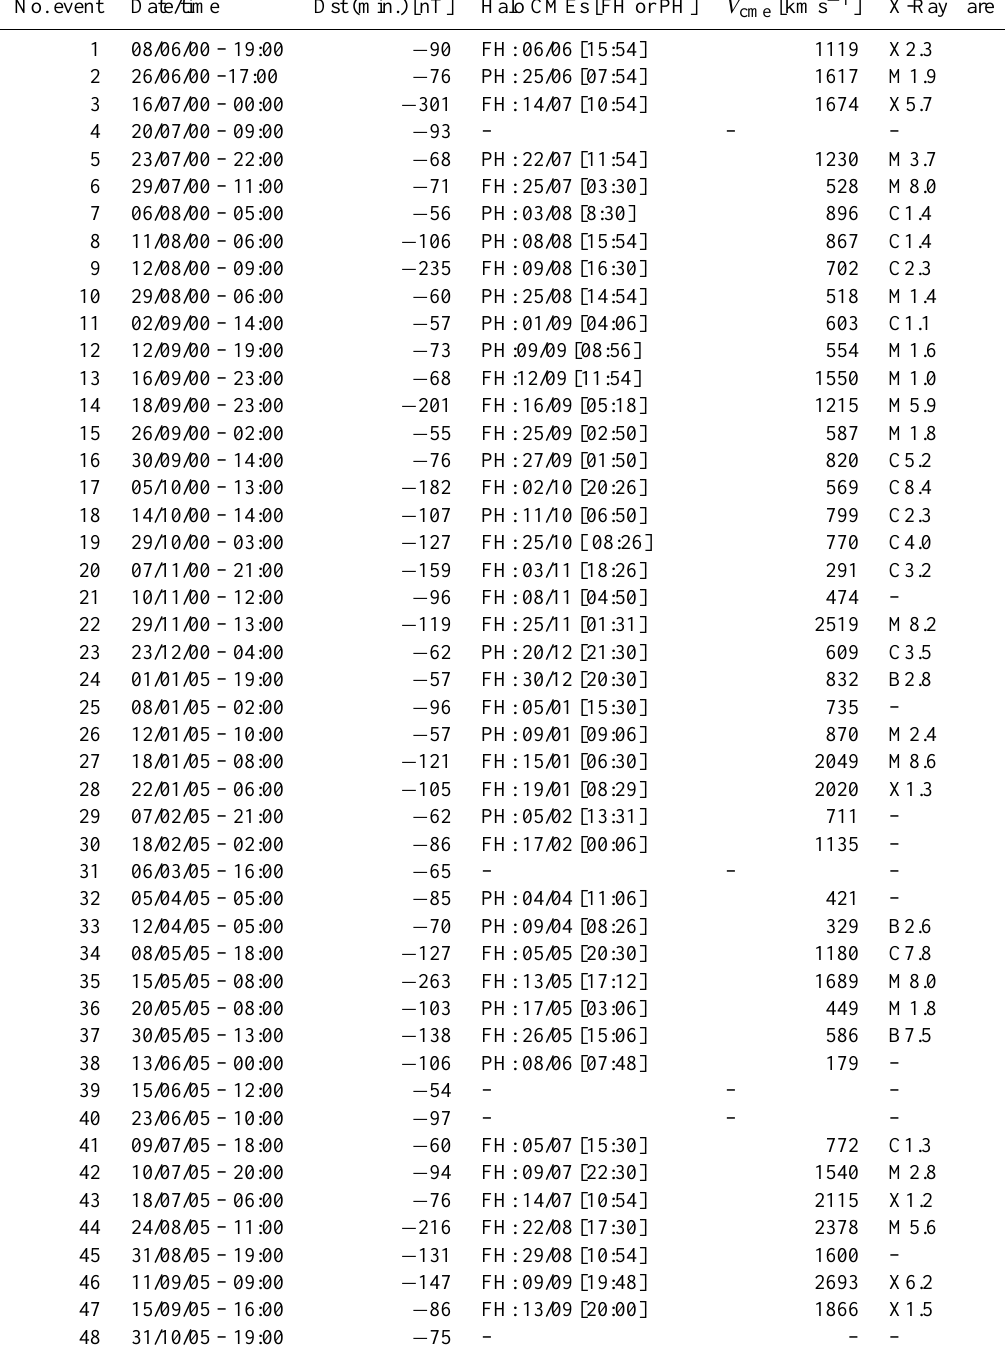
Table 3. Magnetic storm events and associated halo CME characteristics used for the validation data set. Only 43 of the 48 storm events were halo CME-driven. FH and PH in column 4 indicate full and partial halo CME respectively. No.